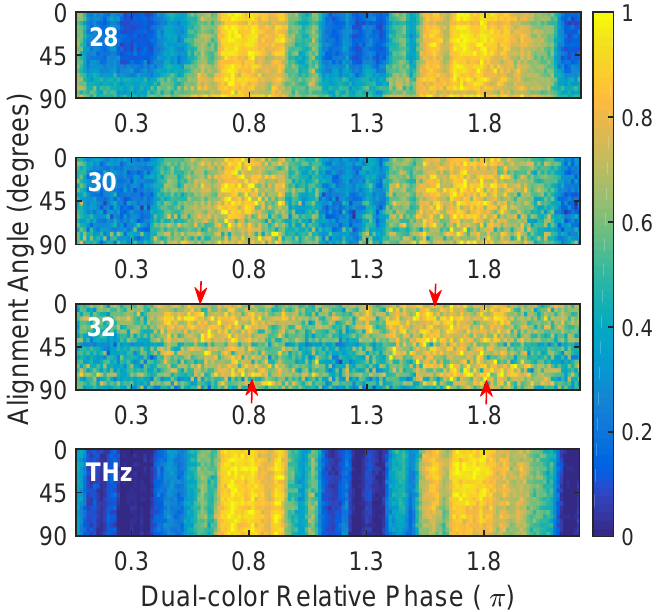
Figure 10. The normalized yield of even harmonics from H28 to H32 as a function of the aligned angle Θ and the dual-color relative phases with the THz phase reference for nitrogen. Experimental data are normalized under each alignment of different harmonics and THz wave, respectively. The red arrows help to find the phase variations of H32 from N 2 between the parallel and perpendicular